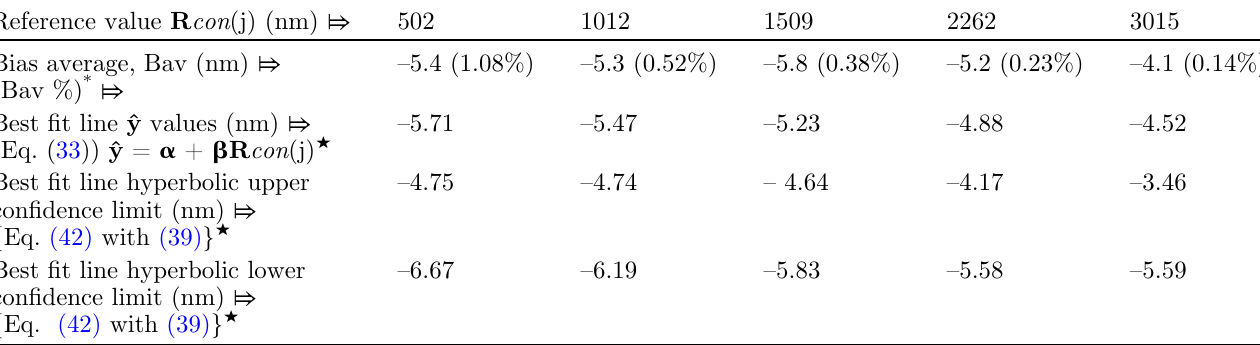
Table 14. Example 6. FAC-1; system D; linear regression analysis results; best fi t